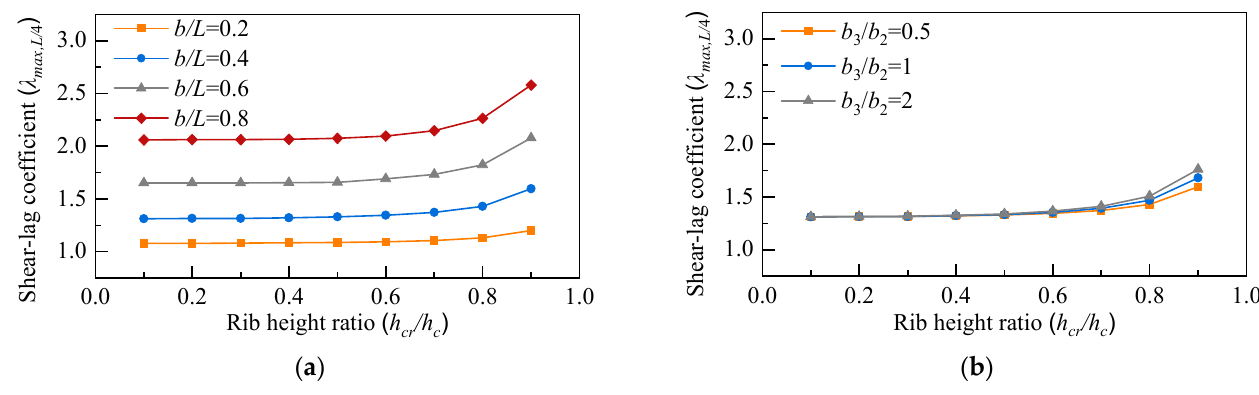
Figure 16. Relation curve of h cr /h c and λ max,L /4 : ( a ) different b/L , ( b ) different b 3 / b 2 .